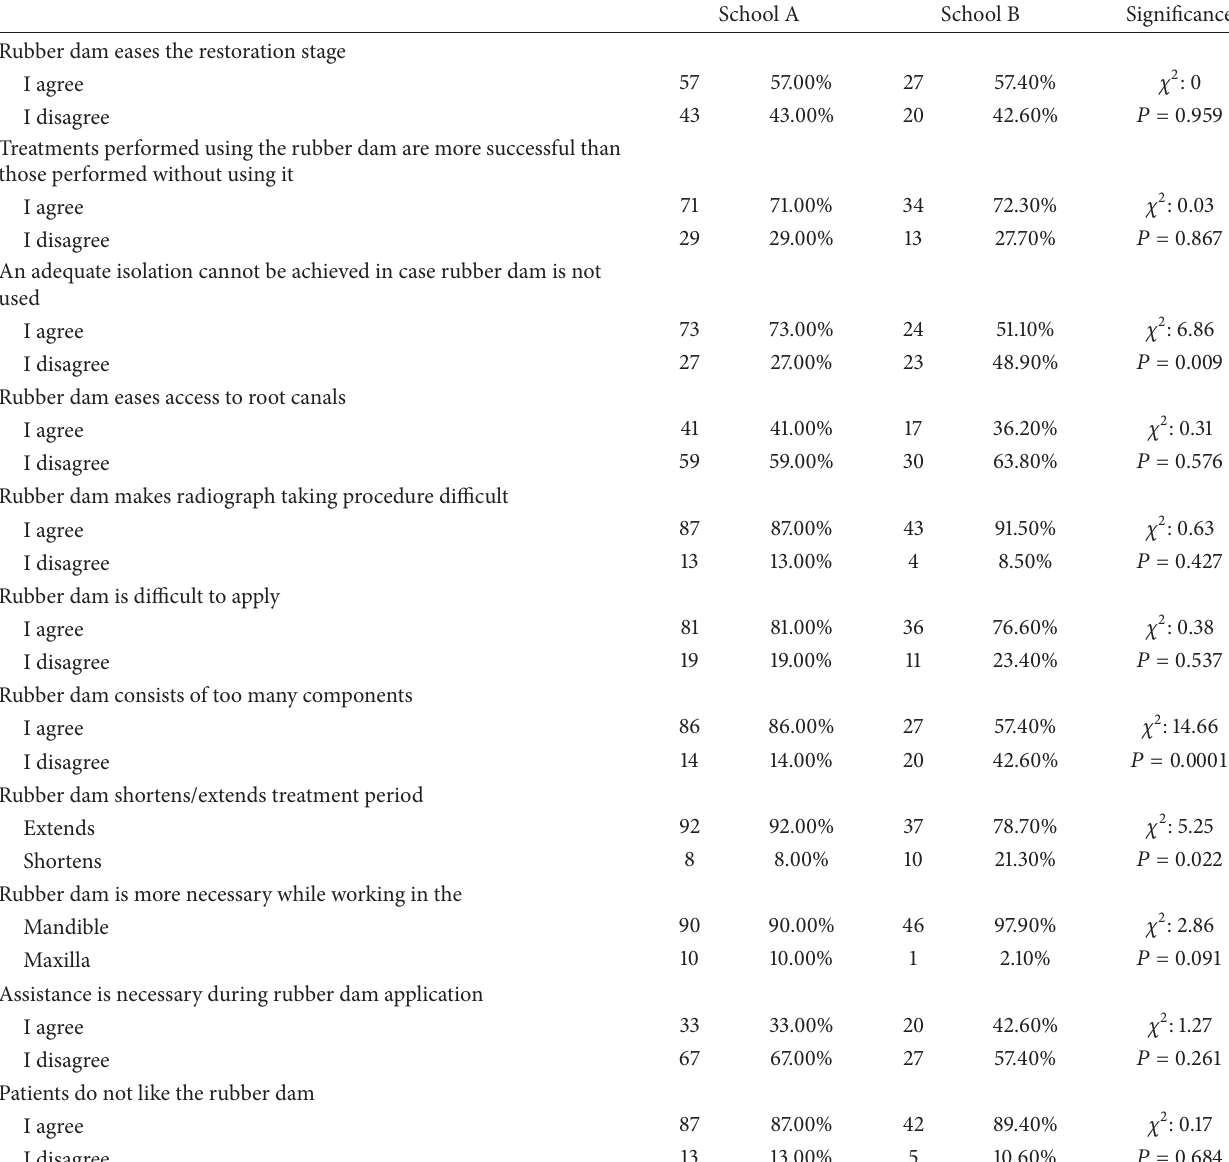
Table 4: Agreement or disagreement of students regarding various aspects of rubber dam.